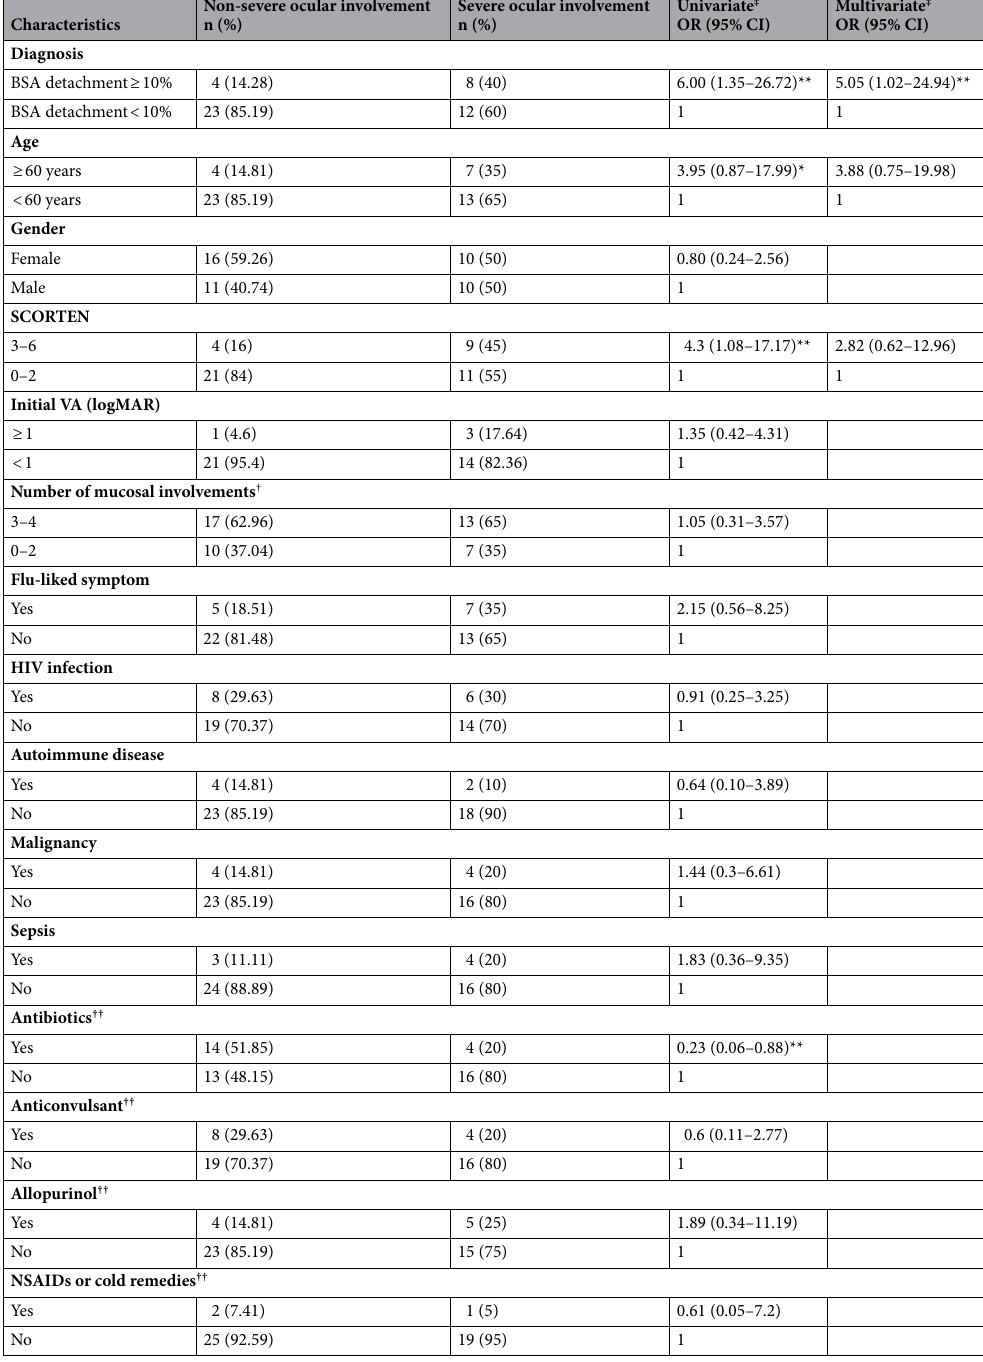
Table 1. Analysis of the correlations between patient characteristics (demographic and clinical parameters) and acute severe ocular complications in SJS/TEN patients. BSA body surface area, SJS